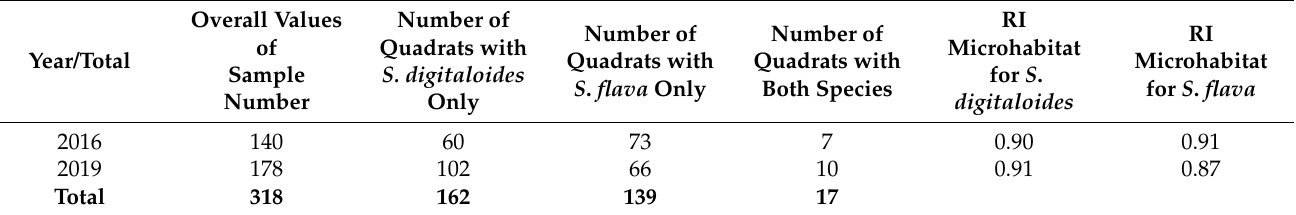
Table 2. Microhabitat occurrence and co-occurrence of Salvia digitaloides and S . flava within 50 × 50 m quadrats at the study sites conducted in 2016 and